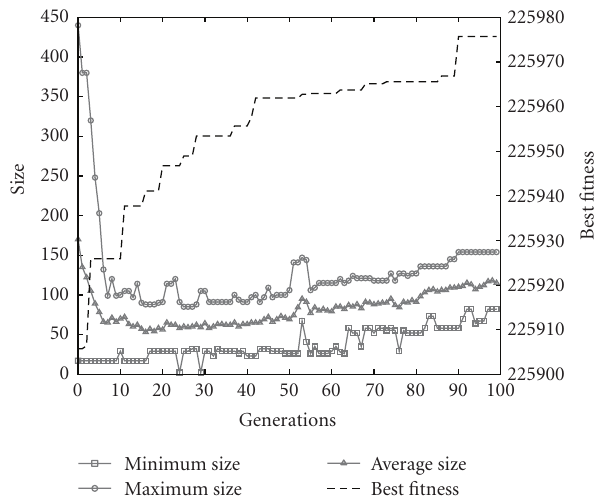
Figure 9: Symbolic regression Experiment 4: chromosome sizes and best fitness.